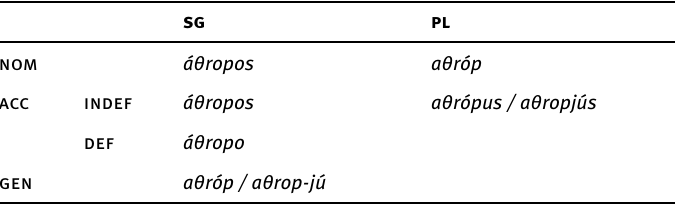
Table 9. Animate declension in Northeast Cappadocian and at Axó sg